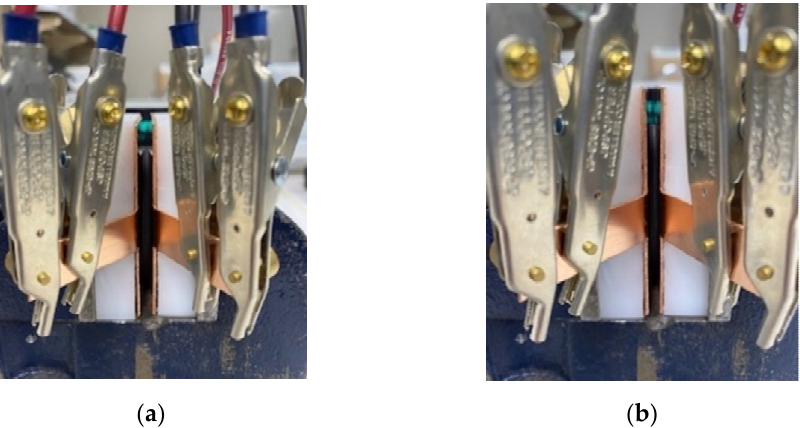
Figure 1. ( a ) Experimental setup for O-ring resistivity testing at 0% compression. ( b ) Experimental setup for O-ring resistivity testing at 30% compression.